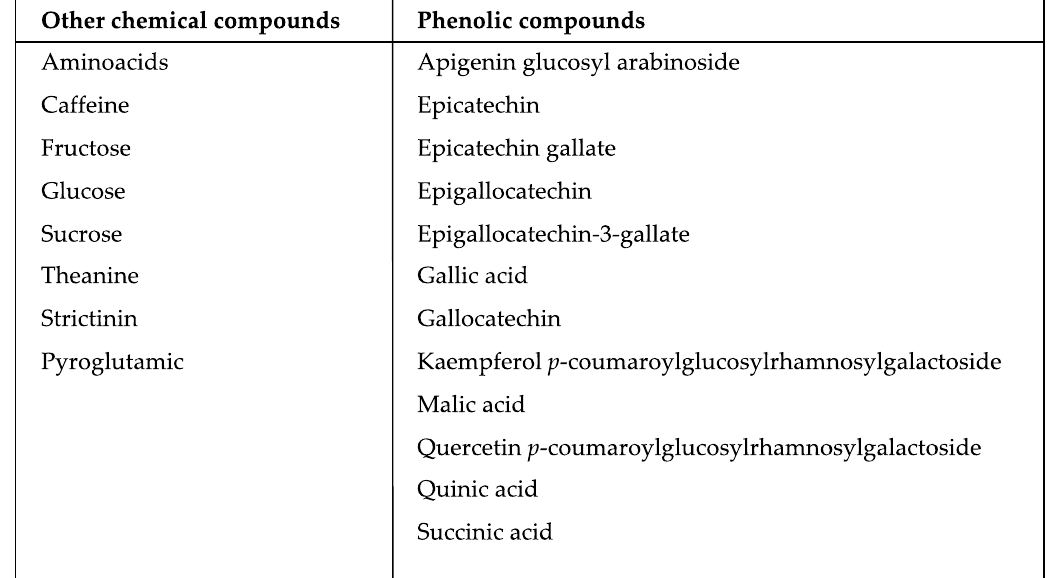
Figure 1. Chemical compounds in Camellia sinensis .